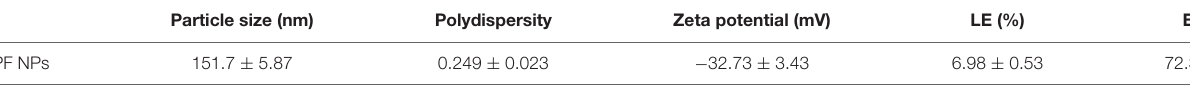
TABLE 2 | Characterization of PF